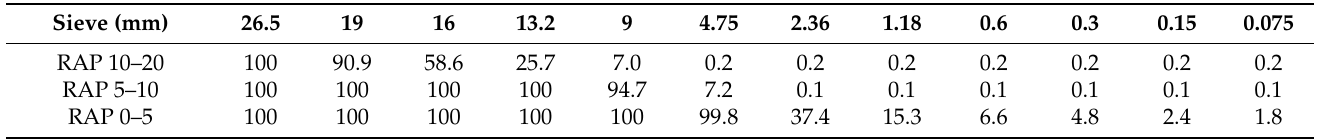
Table 1. RAP aggregates gradation of